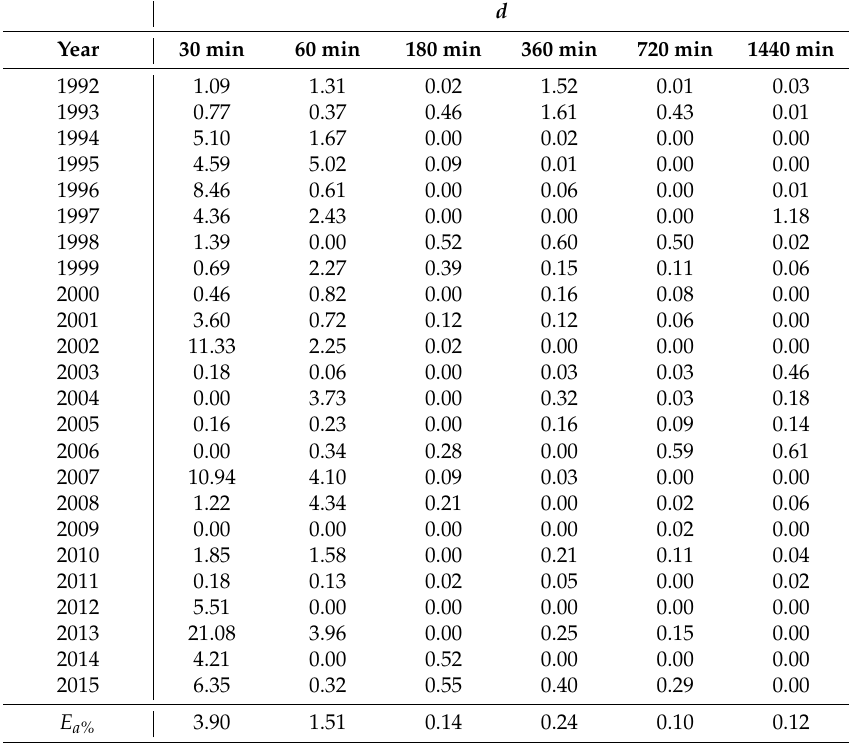
Table 4. Single underestimation errors, E % , (in %) in the determination of the annual maximum rainfall depth considering rainfall data with temporal resolution equal to 15 min and various durations, d , at the Nocera Umbra rain gauge, located in the Umbria Region. For each d , the average underestimation error, E a% , is also